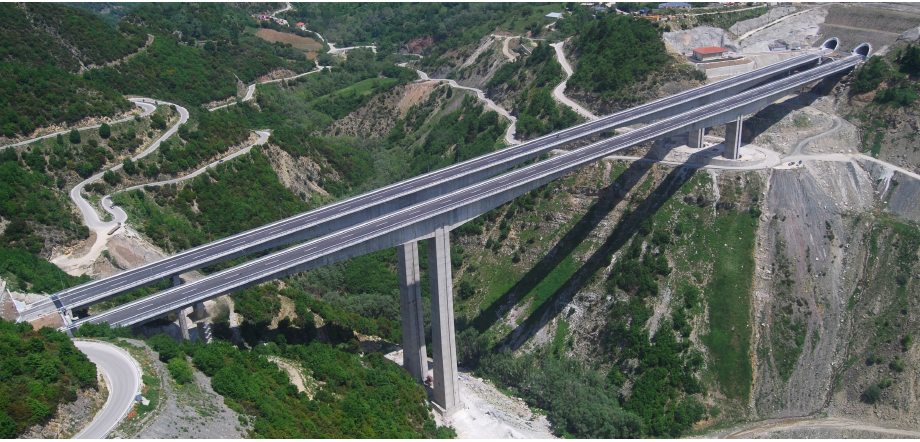
Figure 1. Picture of the Metsovo